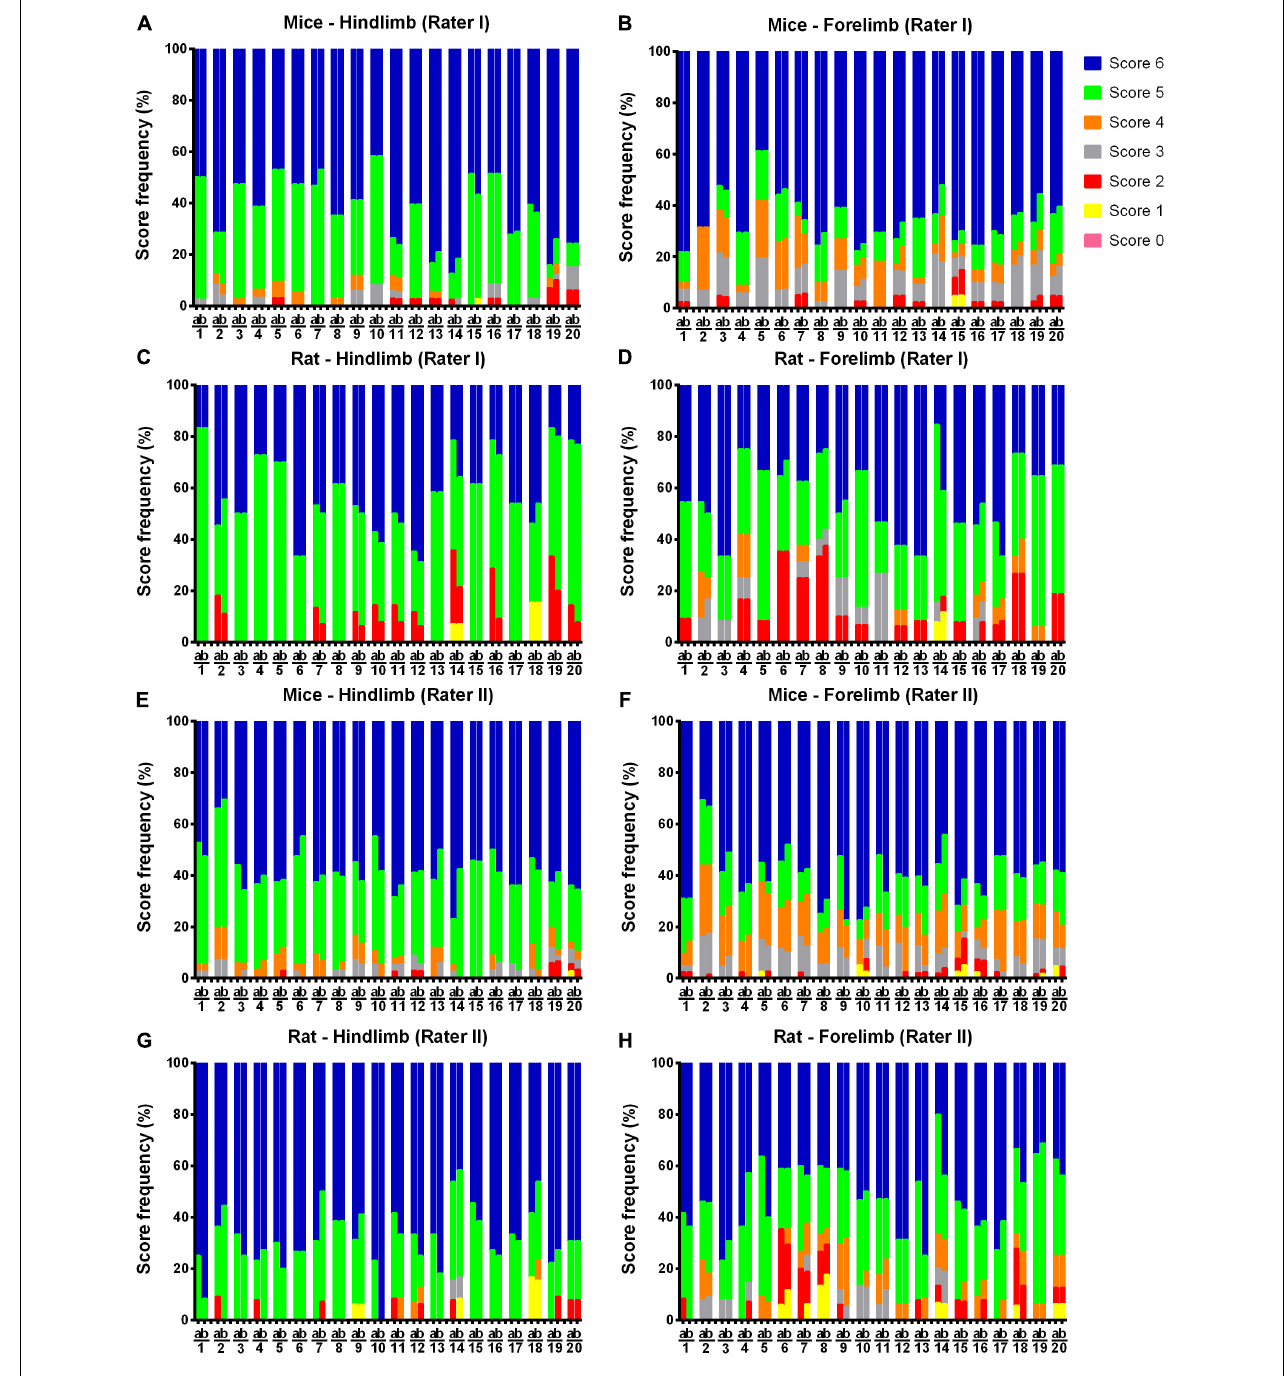
FIGURE 5 | Frequency (%) of each foot placement rate (from 0 to 6) in the first (a) and second (b) assessment by raters I and II. Note that the overall rate distribution pattern was similar between raters and trials. (A–D) : scores attributed by rater I; (E–H) : scores attributed by rater II.